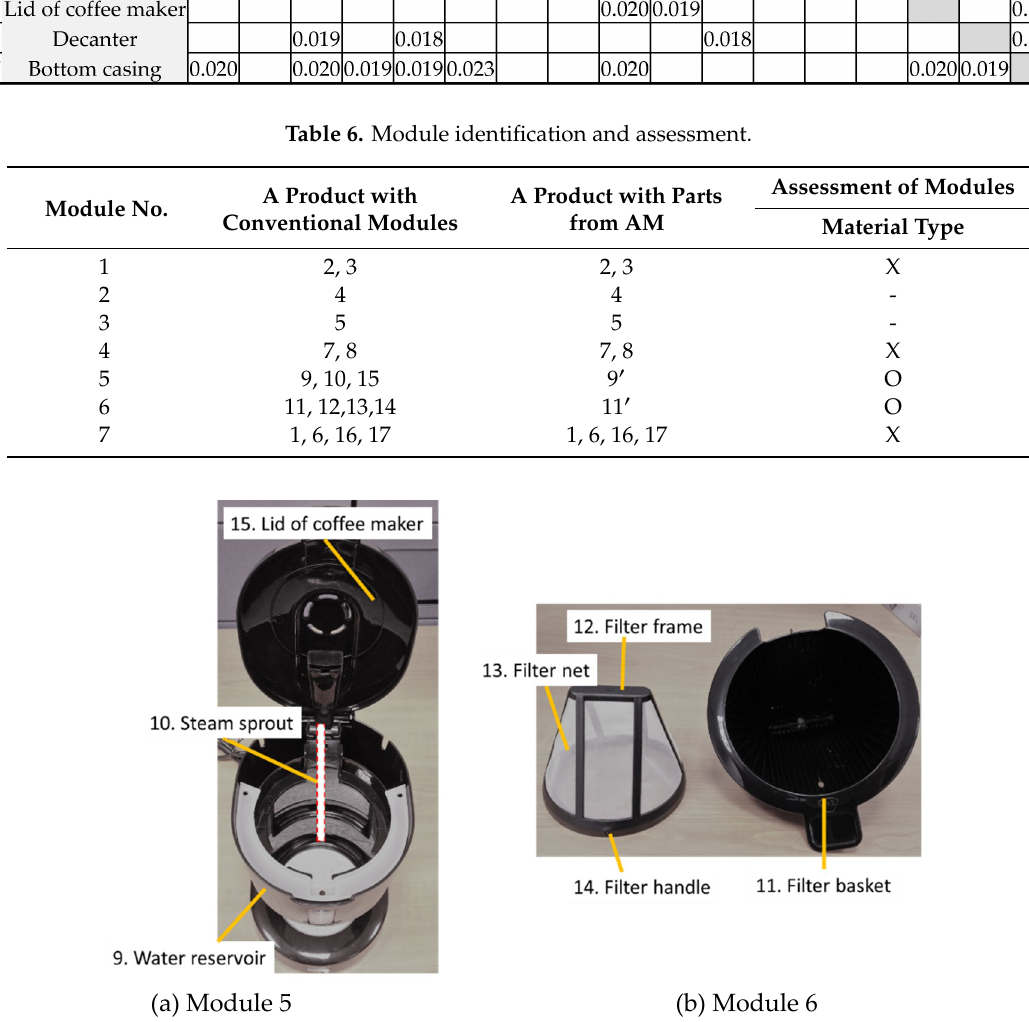
Figure 4. Parts in selected modules for part consolidation.